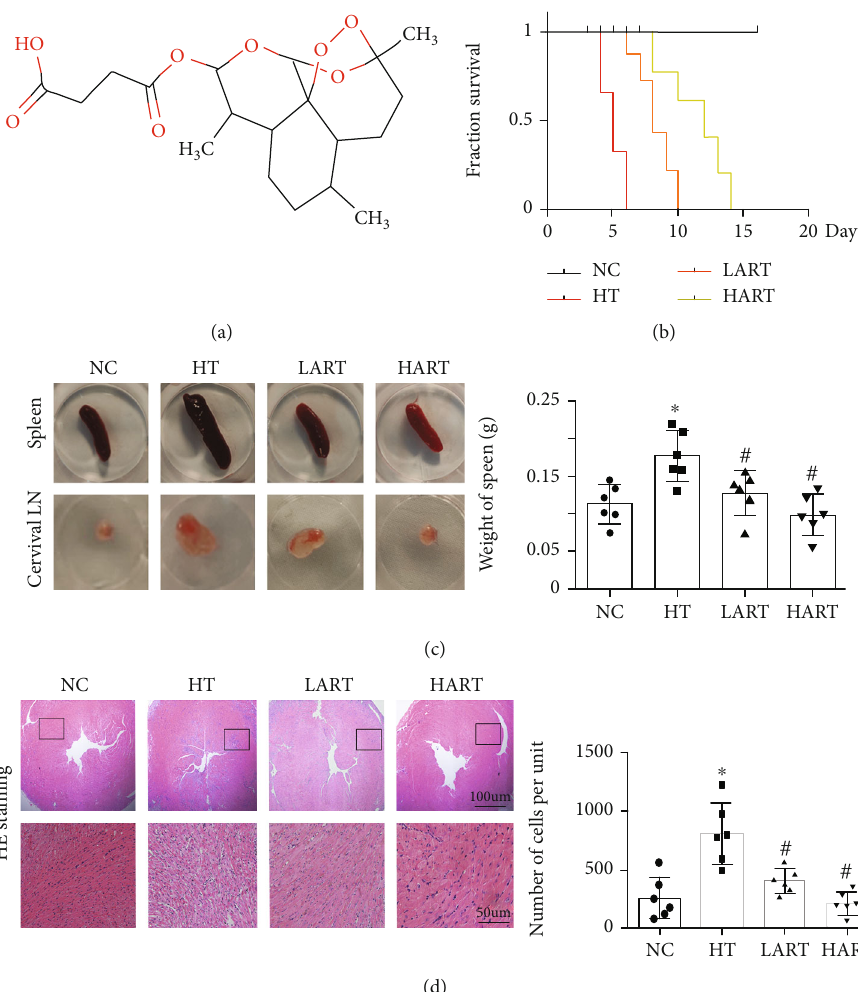
Figure 1: (a) Chemical molecule structure diagram of ART; (b) survival curve of grafts ( n = 6 ); (c) the appearance of cervical lymph nodes and spleen in di ff erent groups; (d) weight of spleens from di ff erent groups; (e) HE staining of heart tissue and statistics graph of cells ’ number per unit ( ∗ P < 0 : 05 compared with NC; # P < 0 : 05 compared with